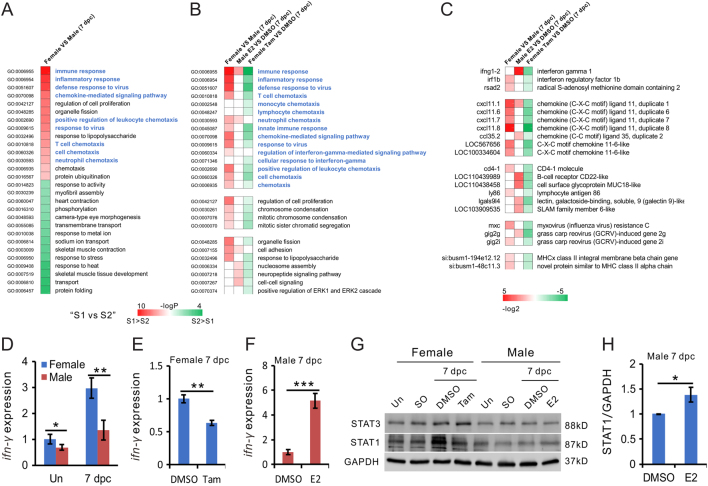
Estrogen induces inflammation in the injured zebrafish heart. A. Gene Ontogeny (GO) terms significantly enriched in genes differentially expressed in female vs male hearts at 7 dpc, n = 3. (B) Comparison of gene expression patterns at 7 dpc in the hearts of female vs male, E2 (1 nM)-treated male vs untreated male, and tamoxifen (1 μM)-treated female vs untreated female, n = 3. (C) Expression of immune and inflammation-related genes in the datasets, n = 3. (D, E and F) Expression of ifn-γ at 7dpc in female and male zebrafish heart and uninjured fish (D). Tamoxifen decreased (E) and E2 increased (F) the expression of ifn-γ in females and males at 7 dpc. n = 4, two-tail t test, *P < 0.05, **P < 0.01, ***P < 0.001. (G and H) Western blot of STAT1 and STAT3 in female and male heart at 7 dpc using different treatments. H, bar chart showing the quantification of STAT1 expression in male fish in panel G, n = 3, two-tail t test, *P < 0.05.